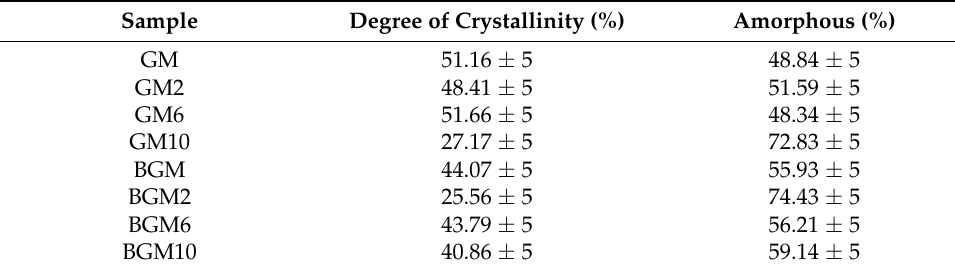
Table 2. Degree of crystallinity of investigated